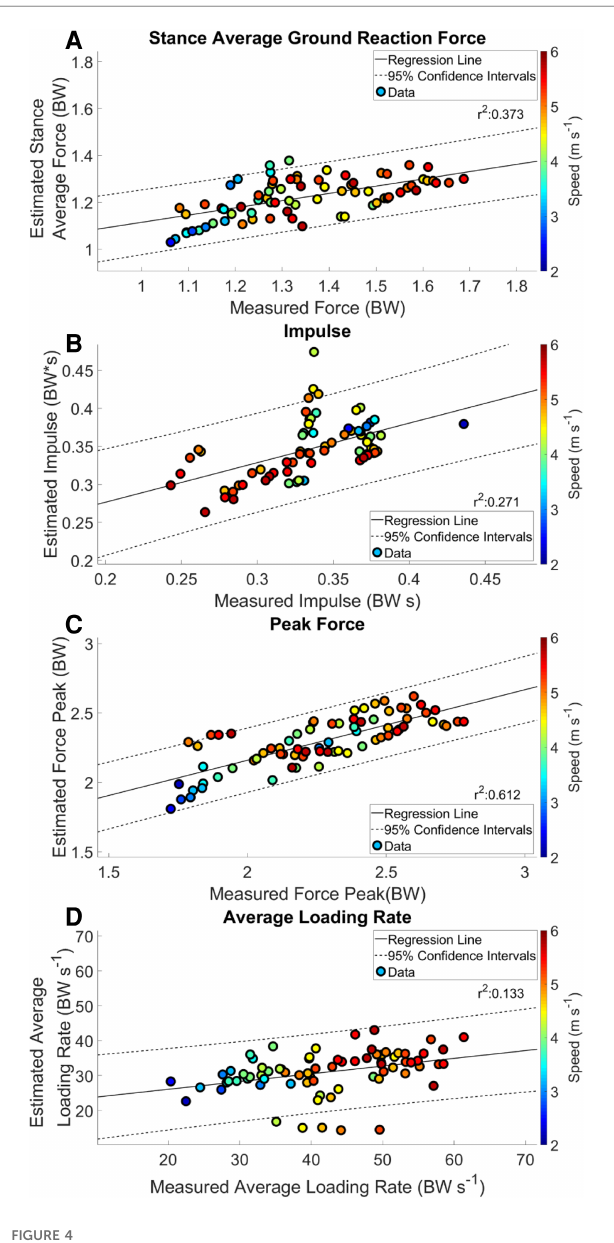
FIGURE 4 Regression analysis of estimated kinetic variables with mean and 95% con fi dence intervals. Each data point represents an average speed trial. The color of a trial represents the average running speed of the